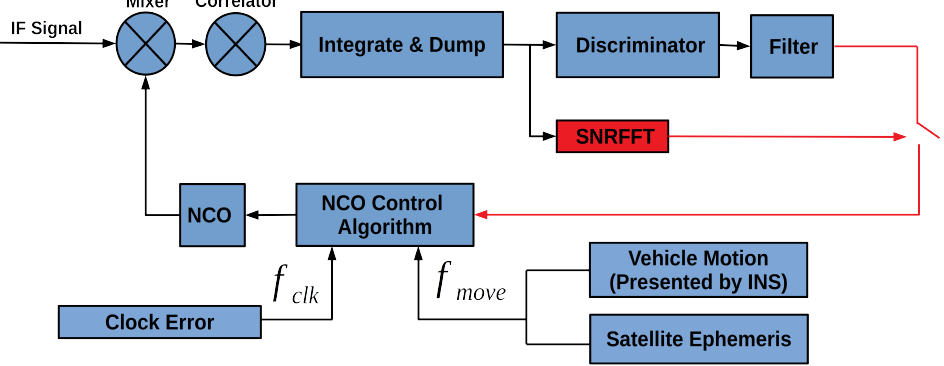
Figure 2. Open-close loop strategy in GNSS/INS Deeply-coupled Software-defined Receiver